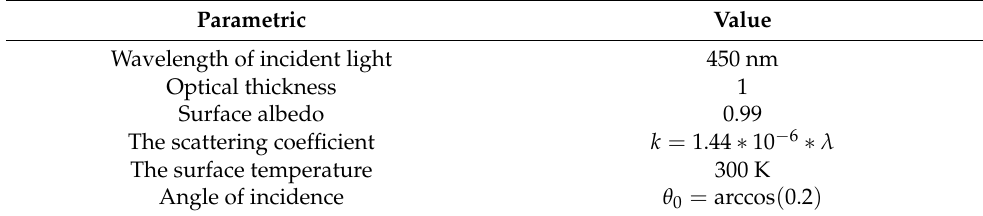
Table 2. Validation parameter values for simulation